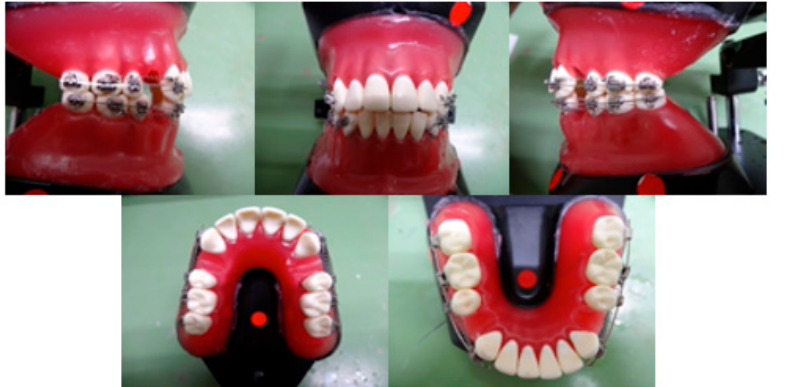
Figure 2. Effects of 2-methacryloyloxyethyl phosphorylcholine (MPC)-coated wires on experimental tooth movement in vitro.